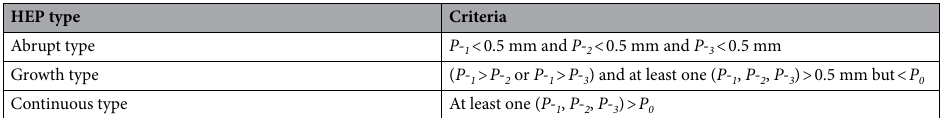
Table 2. Classification criteria for the tree types of summer HEP based on the characteristics of earlier 3-h precipitation evolution before the occurrence of HEP. P- 1 , P- 2 , P- 3 are the precipitation 3 h before the occurrence of HEP, and P 0 is the HEP threshold.